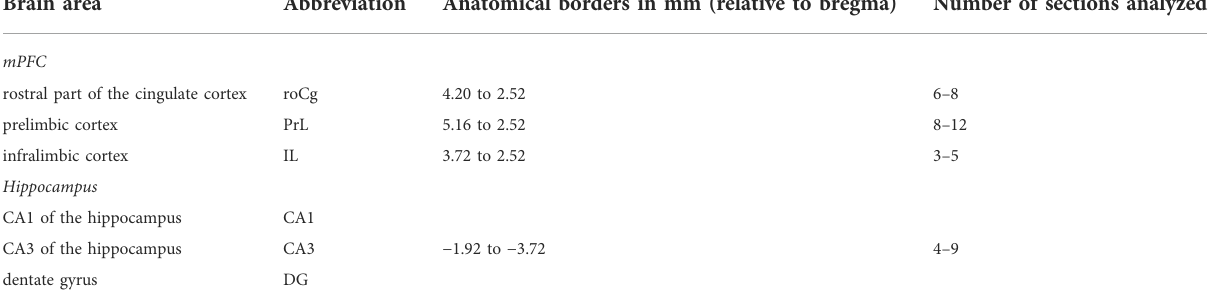
TABLE 1 Anatomical borders of analyzed brain